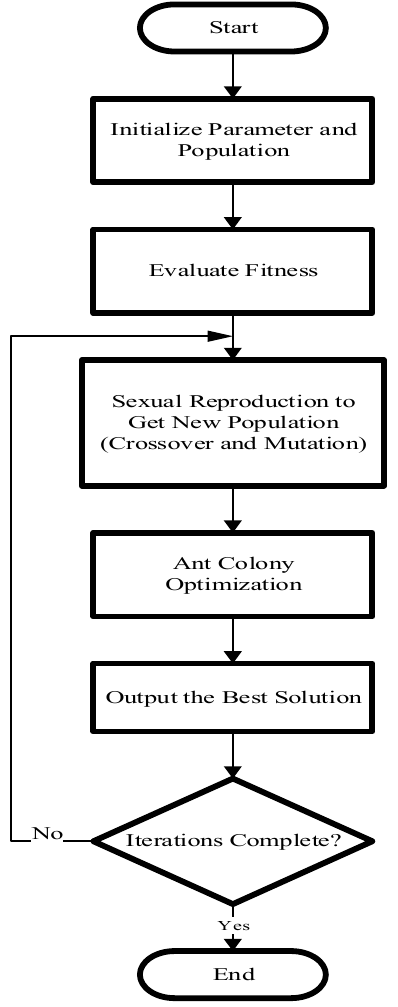
Figure 3. Flowchart of the GAACO MPPT controller.